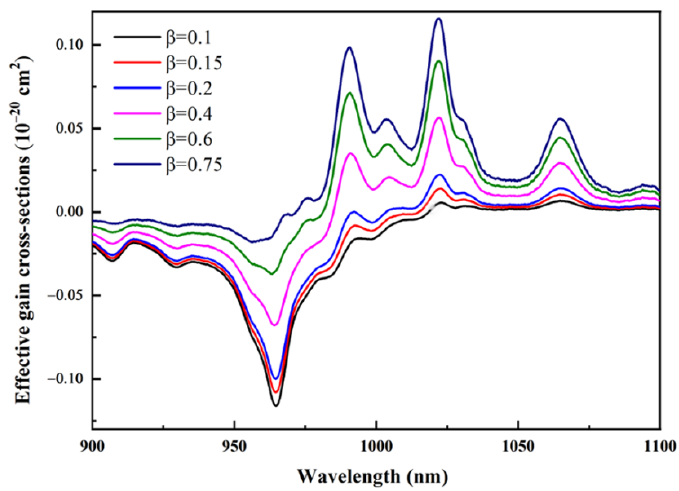
Figure 6. σ g ( λ ) of Yb 3+ :ScBO 3 crystal versus wavelength. (Source: [34], © 2015 Optica Publishing Group, Washington, DC, USA).